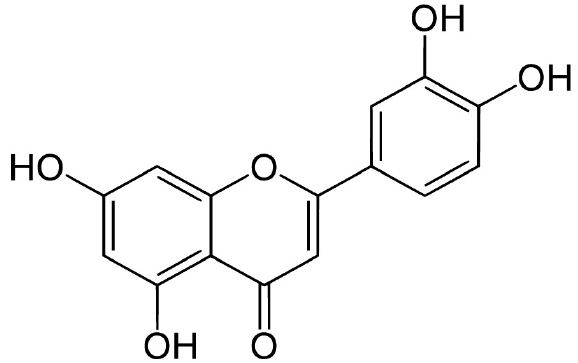
Figure 2. Chemical structure of luteolin.